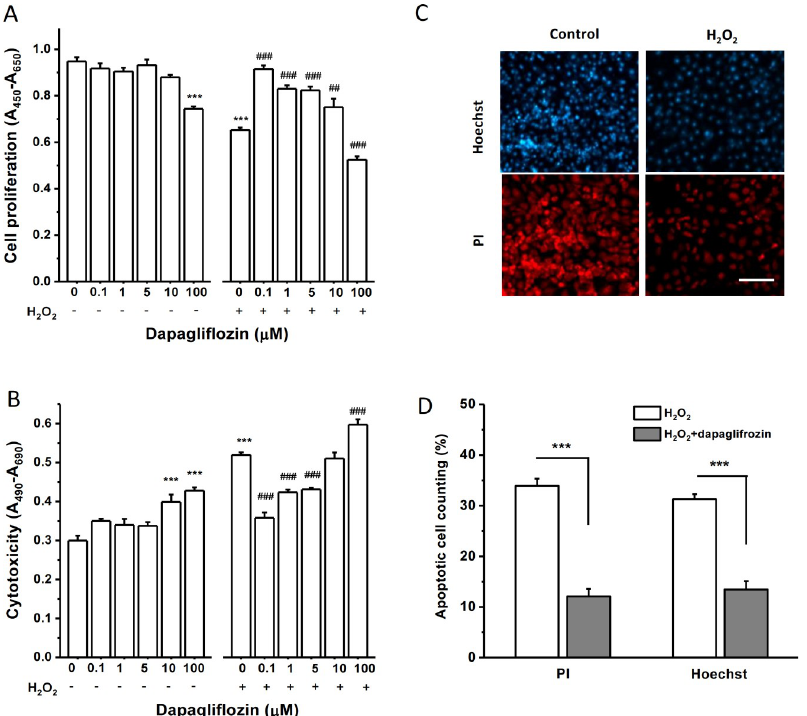
Fig 3. Effects of dapagliflozin on cell growth and death under normal and H 2 O 2 -induced oxidative stress conditions. A, Effect on cell proliferation under normal and oxidative stress conditions mimicked with 200 μ M H 2 O 2 . Cell proliferation was assayed with WST-1 reagents after incubation with dapagliflozin for 24 hours. The absorbance was measured ( n = 8 for each group). B, Cytotoxicity was assayed with LDH reagents after incubation with dapagliflozin for 24 hours, with or without 200 μ M H 2 O 2 ( n = 8 for each group). The absorbance was measured at a wavelength of 490 nm and a reference wavelength of 680 nm. In A and B, ��� P < 0.001 is for the comparison with control, and ## P < 0.01 and ### P < 0.001 for the comparison with H 2 O 2 control group without dapagliflozin. One-way ANOVA with Bonferroni post hoc test was used for group comparisons. C, Examples of nuclear staining with propidium iodide (PI) and Hoechst 33342 (Hoechst). Scale bar = 100 μ m. D, Mean ± SEM data for the percentage of apoptotic cells in the group of H 2 O 2 (200 μ M) and H 2 O 2 (200 μ M) plus dapagliflozin (0.1 μ M). ( n = 6 for each group, ��� P < 0.001 by unpaired t